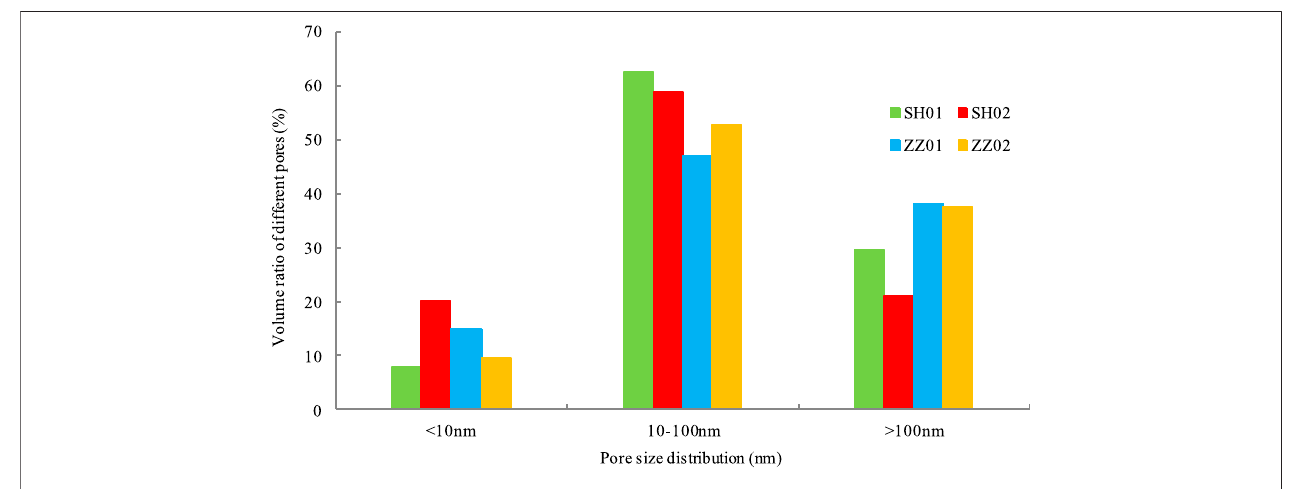
FIGURE 4 | Pore size distribution of coal sample testing by LPN 2 A.